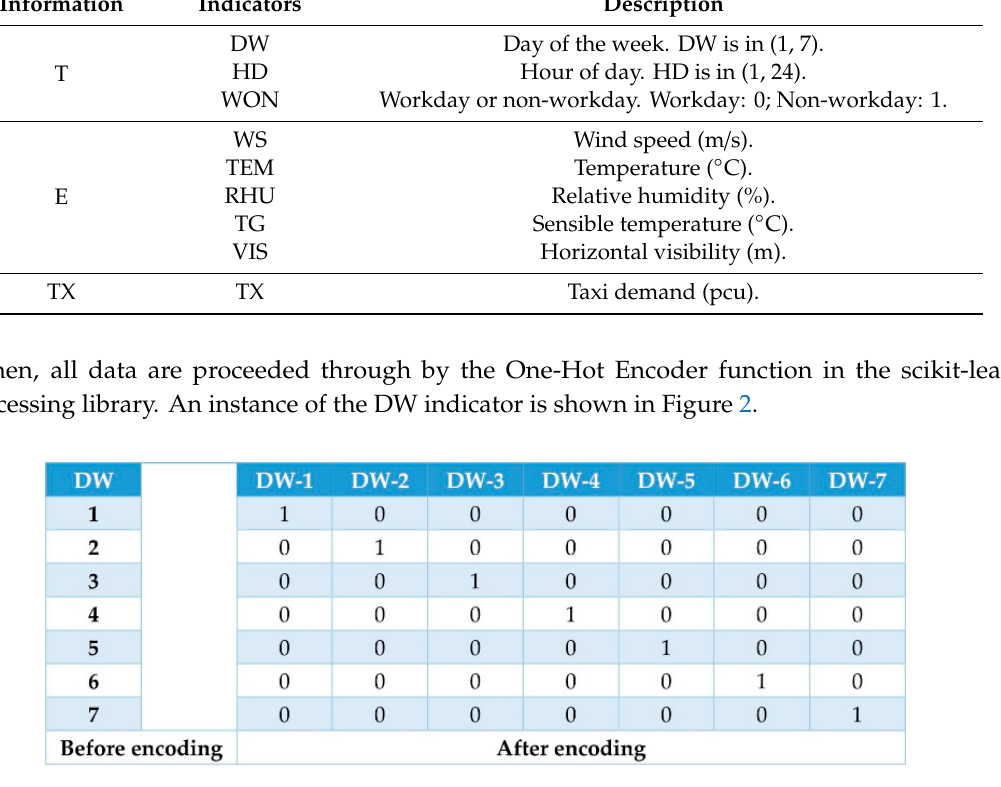
Figure 2. An instance of One-Hot Encoder.